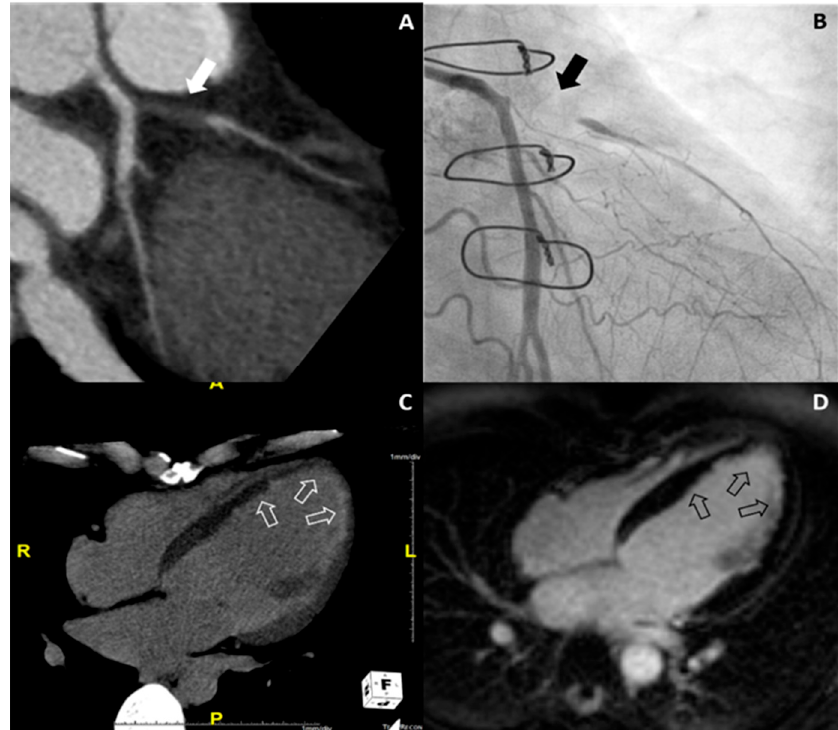
Figure 4. Representative case of ischemic heart failure. On coronary CT angiography ( A ), total occlusion of the proximal left anterior descending artery (white arrow) is noted, and this finding was confirmed on conventional coronary angiography (black arrow) ( B ). On delayed-enhanced dual-energy CT with the four-chamber plane ( C ), subendocardial delayed enhancement is noted on the apical left ventricle and septal wall of the mid left ventricle (white open arrows), which was confirmed on cardiac MR (black open arrows) ( D ).